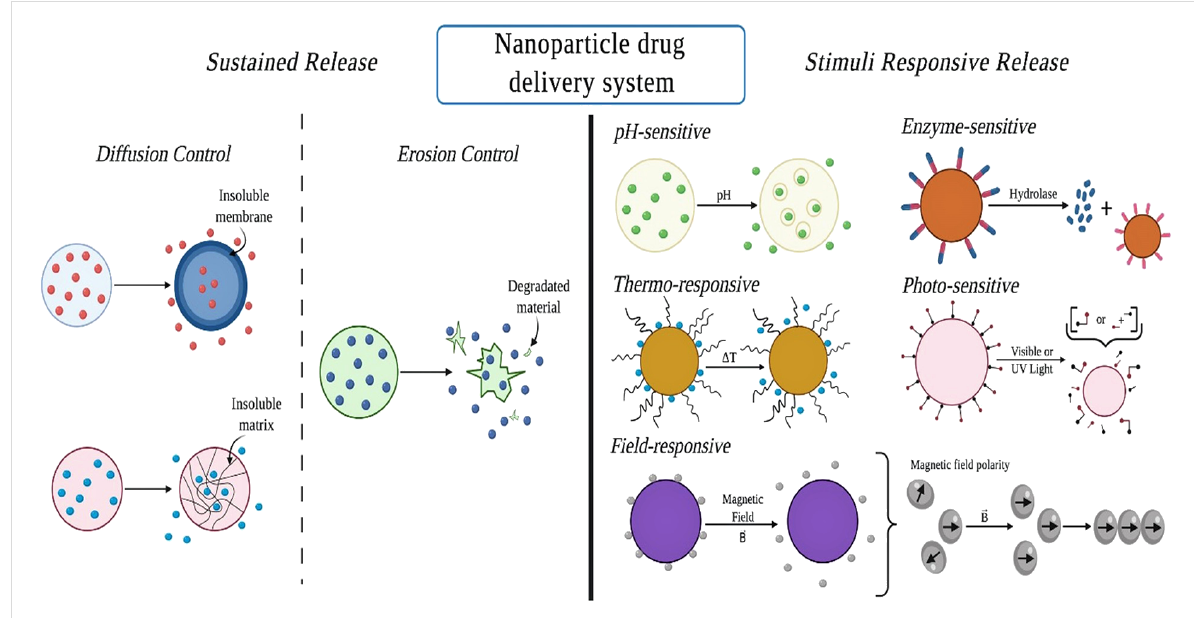
Figure 4: Illustration of the drug release profile of nanomaterials: sustained release and stimuli-responsive release.